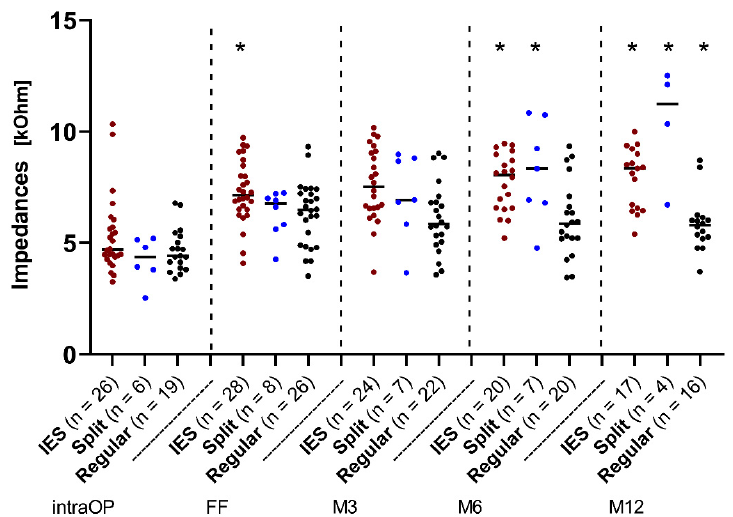
Figure 2. Change in impedances over time across the IES, SPLIT, and REGULAR groups. Median overall electrode contacts C1–C12. Since the number of patients varied over time, the existing patients were additionally marked as individual dots at each point in time. The red dots represent the IES patients, the blue dots represent the patients from the SPLIT group, and the black dots represent the patients from the REGULAR group. Asterisks mark the significant differences between groups.